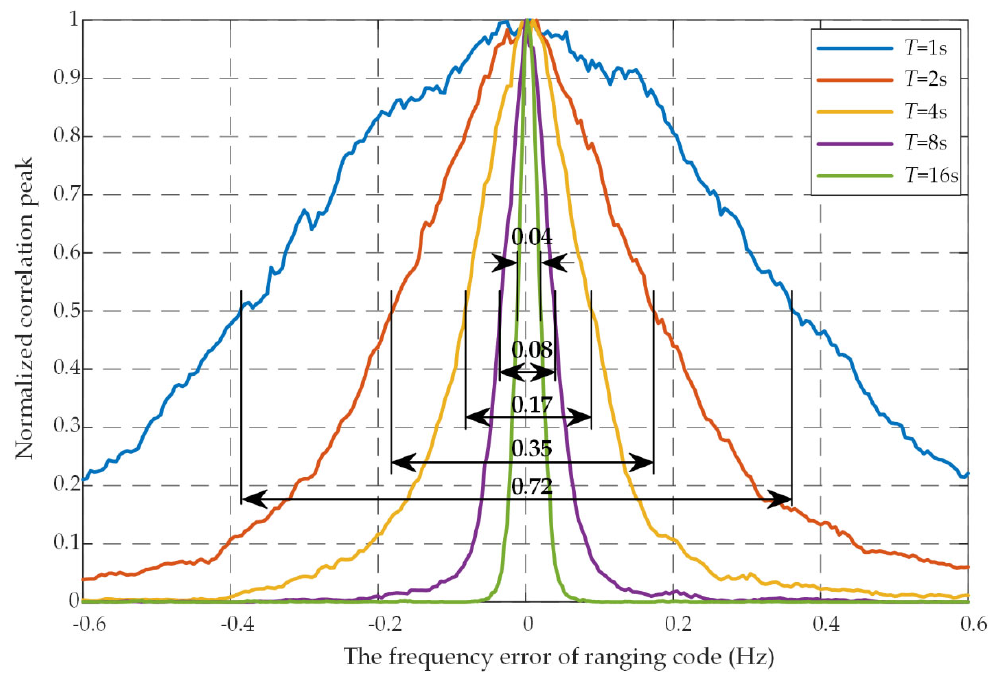
Figure 4. The normalized correlation peak versus on the frequency shift of ranging code under different coherent integration time length.